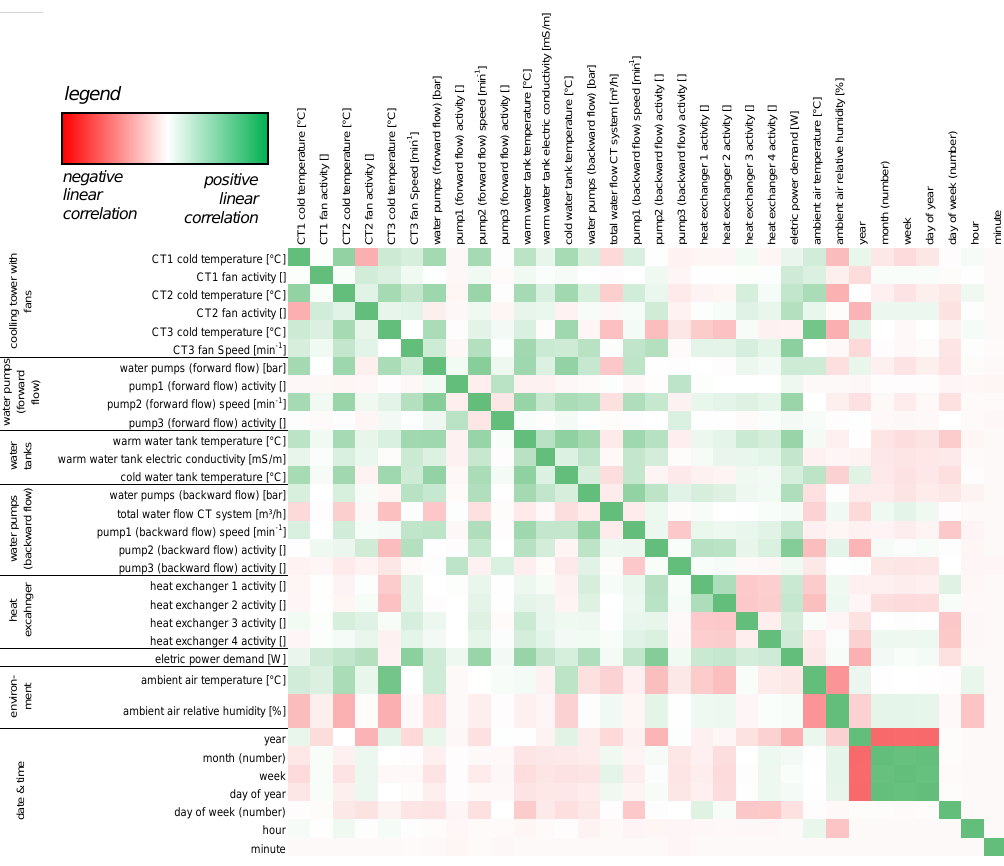
Figure 10. Correlation matrix indicates data interdependencies with positive linear correlation ( green color ) and negative linear correlation ( red color ).